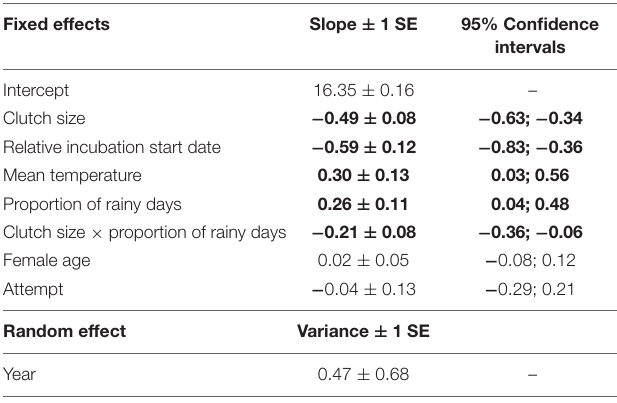
Shown are model-averaged parameter estimates and 95% confidence intervals for each fixed effect, and variance for the random effect from the three best fitting models. Confidence intervals that do not overlap zero are indicated in bold. The model-averaged R 2 LMM ( m ) and R 2 LMM ( c ) were 17.4 and 35.1%,